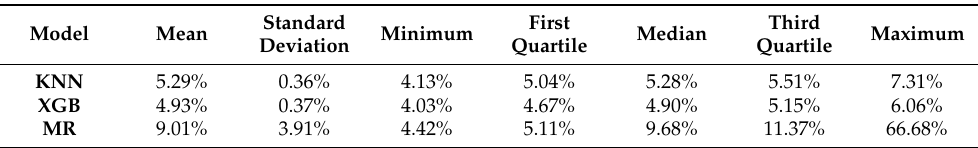
Table 4. Selected measures of a central tendency of relative root mean square errors for the analyzed models in 1000 draws (a training set of 68